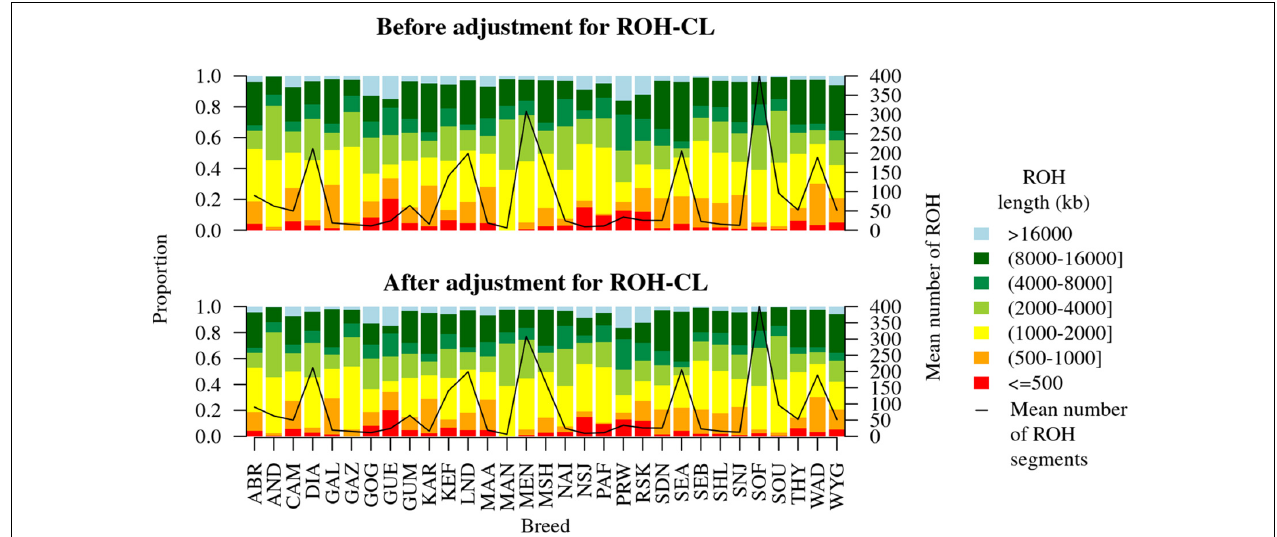
FIGURE 5 | Distribution of ROH sizes before and after adjusting for ROH-CNV copy loss intersections. The two plots differ by from 0 to 0.0168 depending on the breed.